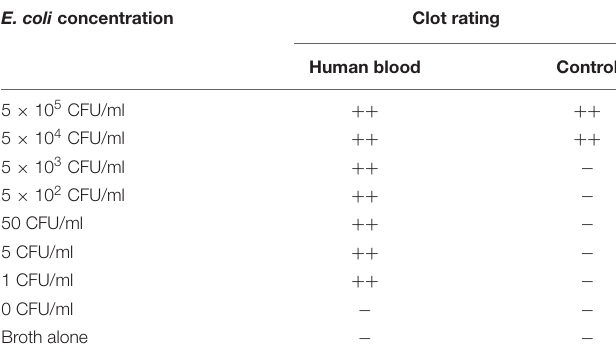
TABLE 2 | Summary of gel clot assays for Escherichia coli detection in human blood. E. coli